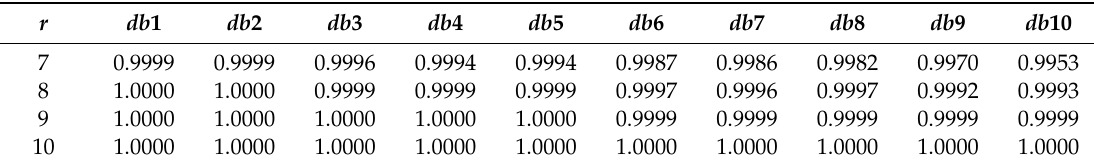
Table 18. Experimental results ( SSIM ) of 3D tomographic 16-bit image “Body_1.0” DWT by using bit-width r of Daubechies wavelets filters coe ffi cients.